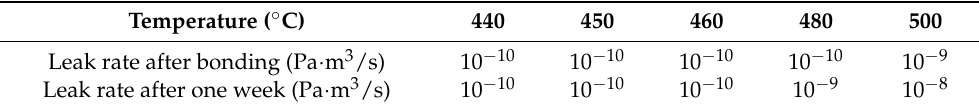
Table 1. Gas tightness of the joint sintering bonded by Ga and Cu NPs at different temperatures. Temperature ( ◦ C) 440 450 460 480 500 Leak rate after bonding (Pa · m 3 /s) 10 − 10 10 − 10 10 − 10 10 − 10 10 − 9 Leak rate after one week (Pa · m 3 /s) 10 − 10 10 − 10 10 − 10 10 − 9 10 −